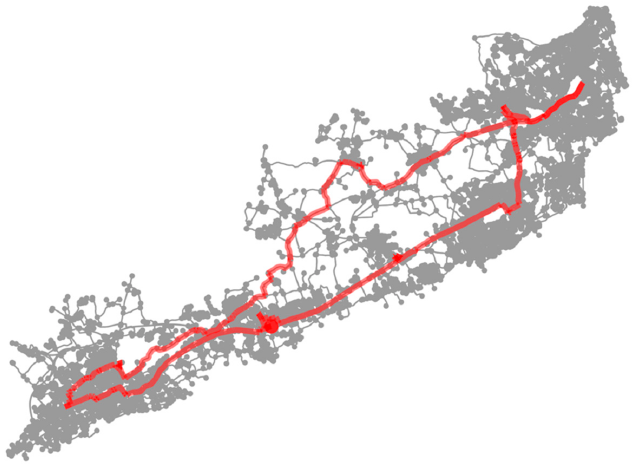
Figure 2. Route optimization.